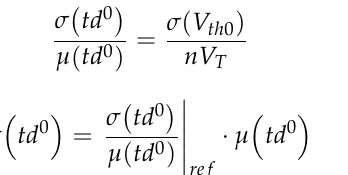
Figure 4 verifies the accuracy of Equation (12) for different gates and driver strengths.